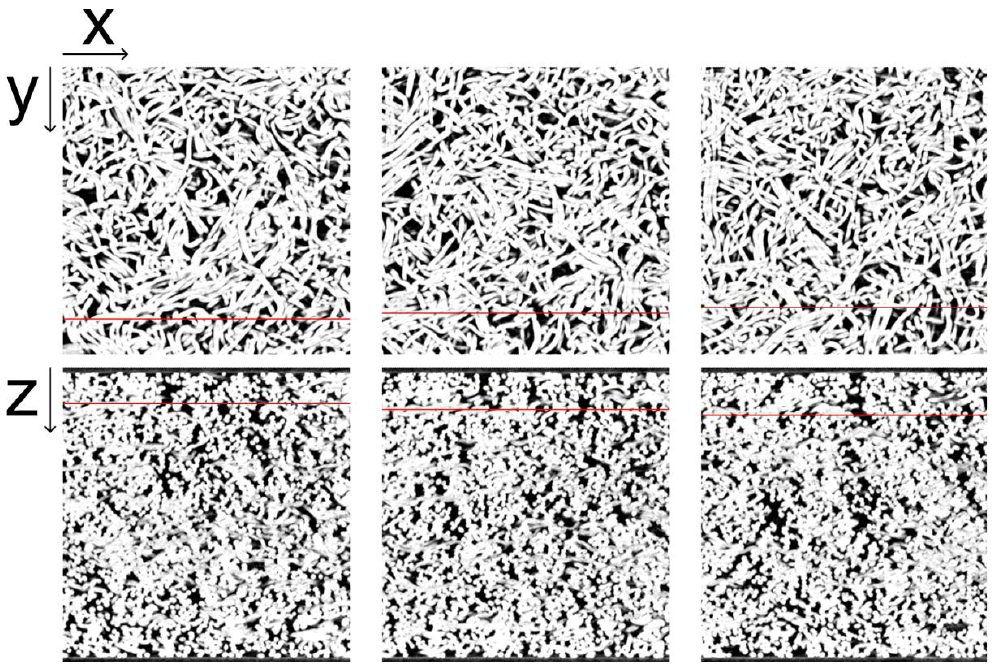
Figure 9. Cross-sectional X-ray computed tomography images of 16-ply laminated product. The upper images are the xy-plane images cut by the red lines in the lower images. The lower images are the xz-plane images cut by the red lines in the upper images. The left, center, and right cut positions are all shifted by 10 μm.